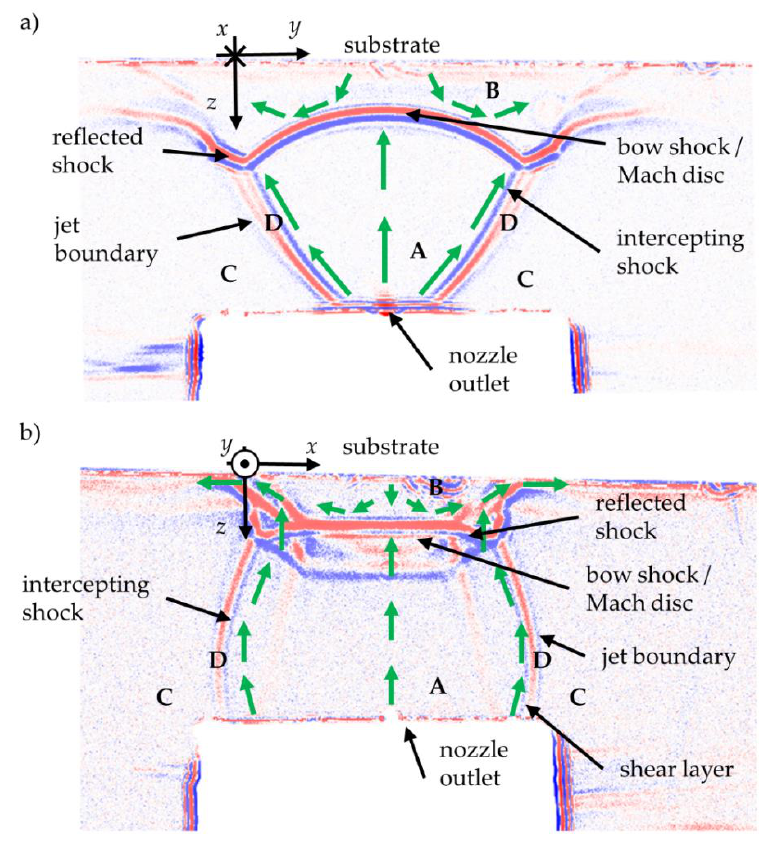
Figure 6. Shadow images of a PAD gas jet expansion, ( a ) y - z plane (slit of the nozzle), and ( b ) x - z -plane (width of the nozzle) with the different density regions A – D.